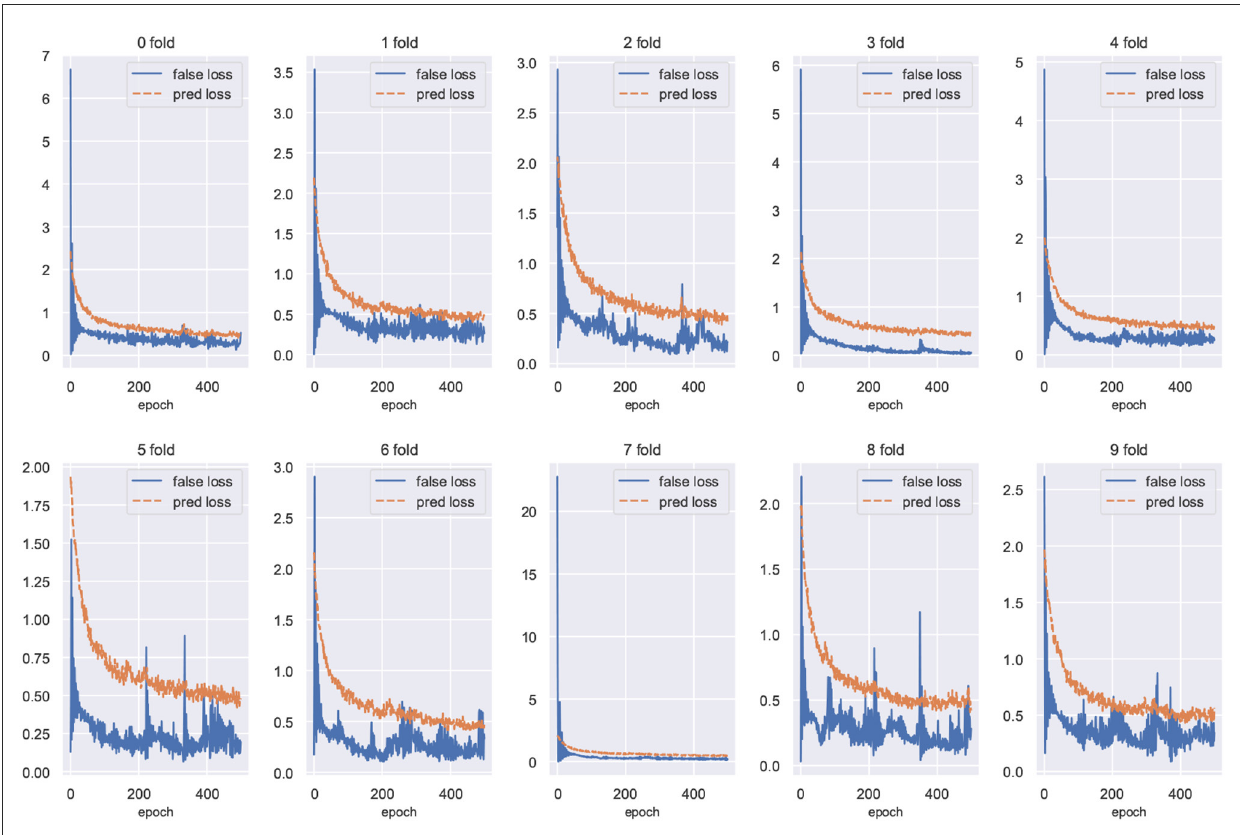
FIGURE9 Training loss curves for cross-validation of the ISRUC-S3 dataset. The loss value of the domain discriminator is represented by the blue curve, and the loss of the domain classifier is represented by the red